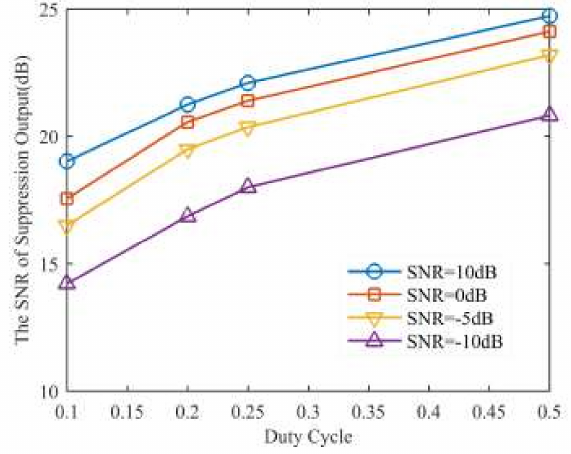
Figure 15. The SNR of suppression results versus duty cycle under different